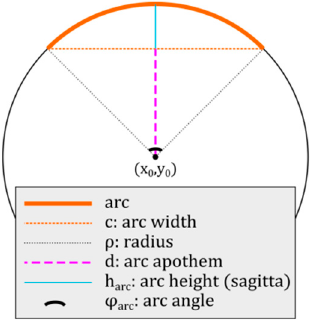
Figure 2. Construction of the geometry.